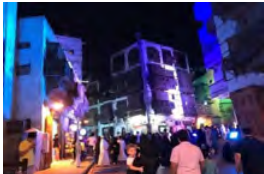
Figure 14. Show the place’s identity while moving through